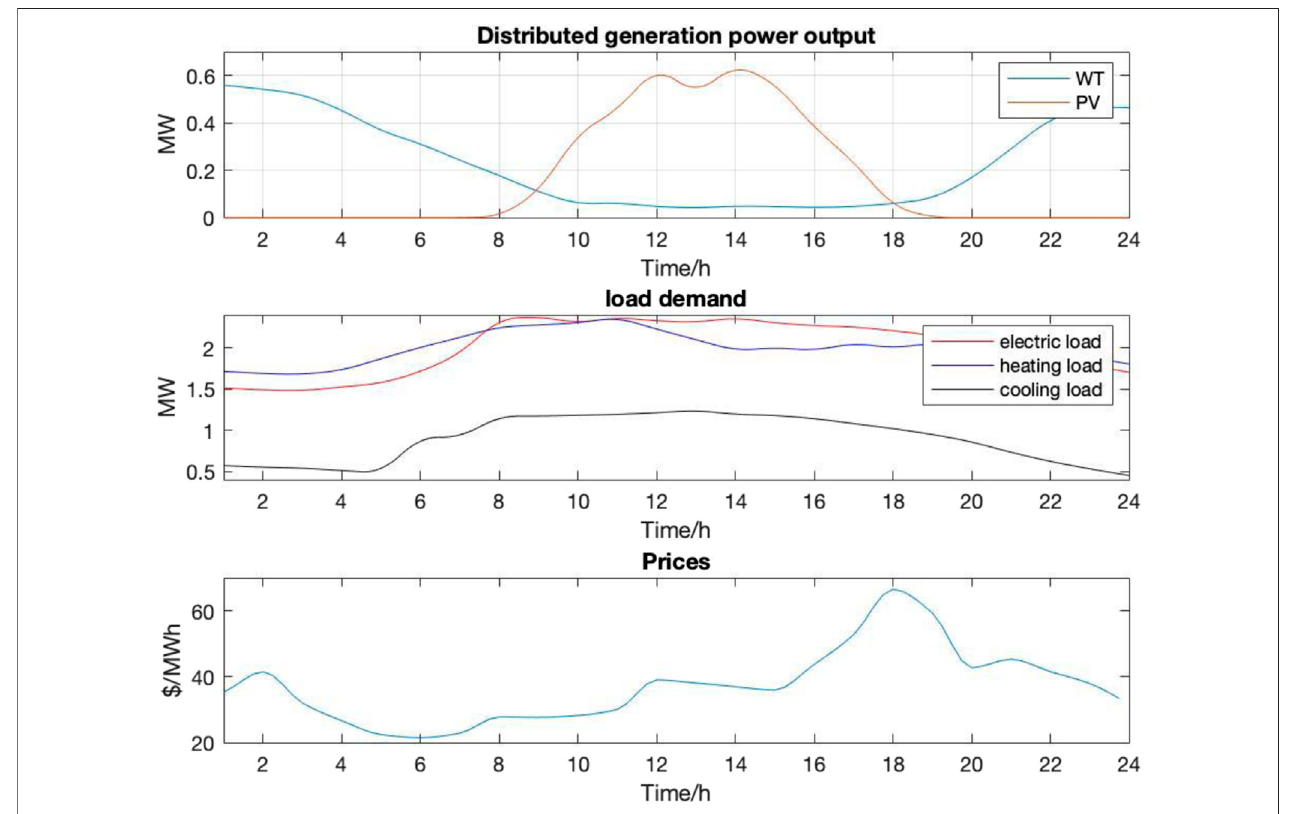
FIGURE 3 | The day ahead electric load, heating load, cooling load, generation, WT, and prices forecasting.